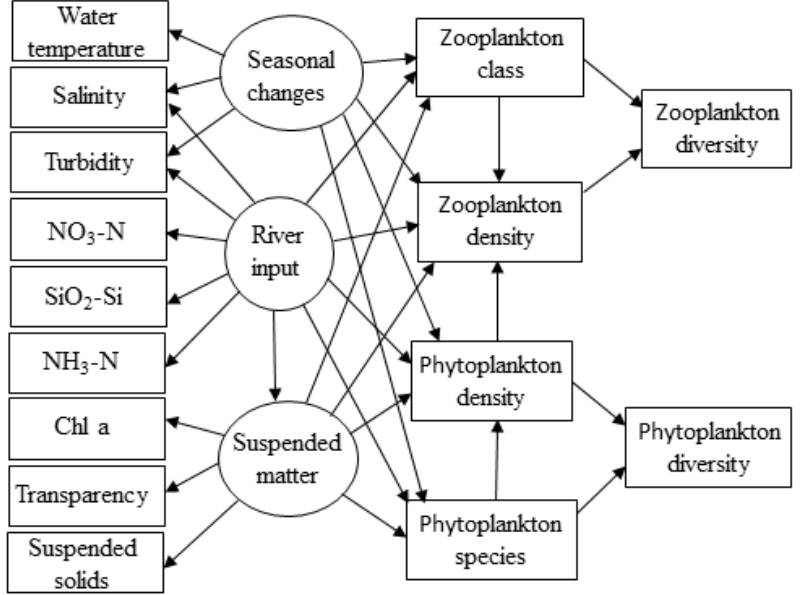
Figure 3. The conceptual model used for exploring the influence of abiotic parameters on phyto- plankton and zooplankton density and diversity in the study area.